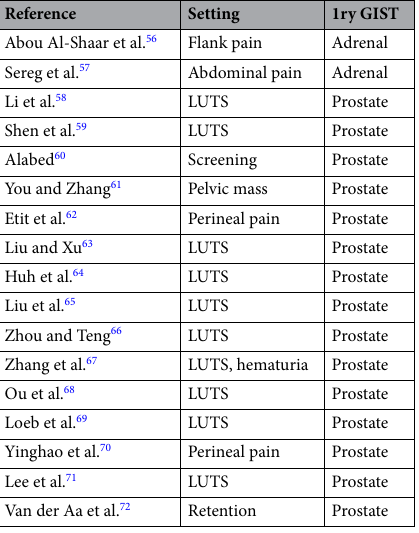
Table 4. Case reports of primary GU organ EGIST. EGIST extra gastrointestinal stromal tumor; LUTS lower urinary tract symptoms.